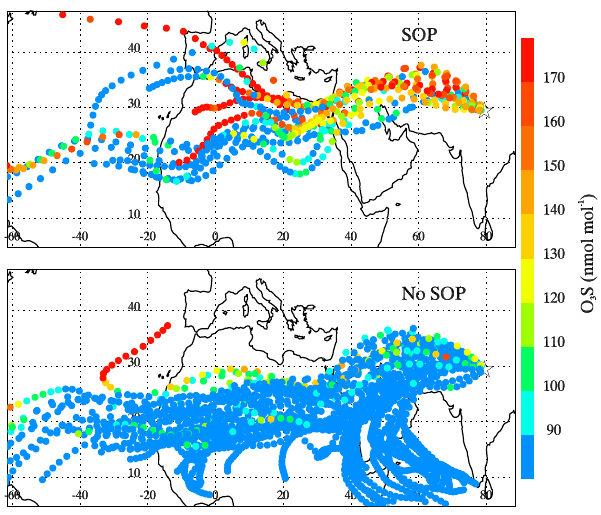
Figure 6. EMAC-simulated evolution of O 3 s along 5-day backward air trajectories over Nainital during SOPs and non-SOPs with start- ing altitude of 11km for the month May 2002. The difference be- tween symbols on trajectories represent a time period of 3h. The location of the Nainital site is shown by the star